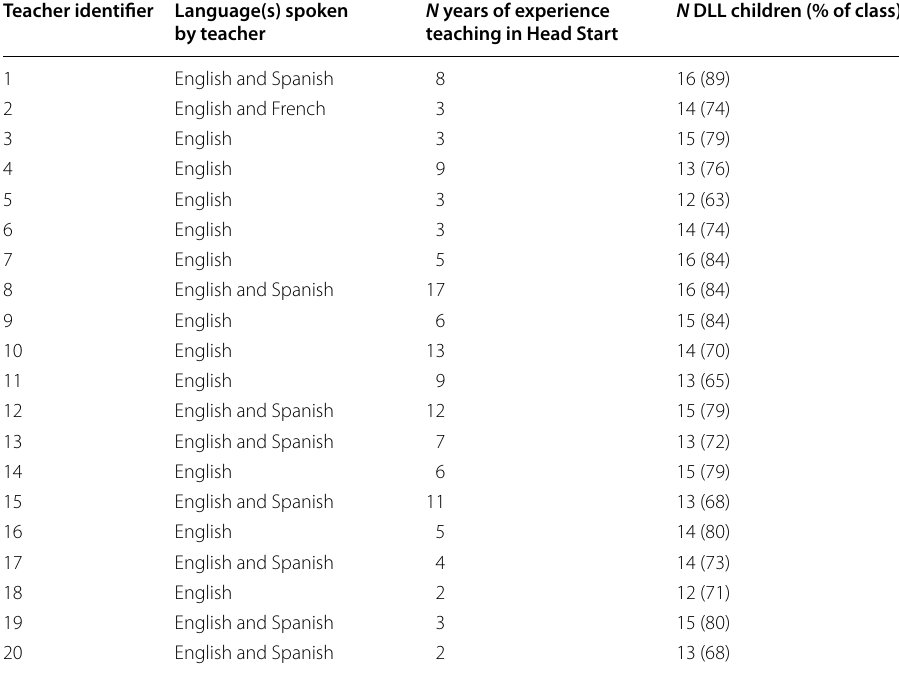
DLL dual language